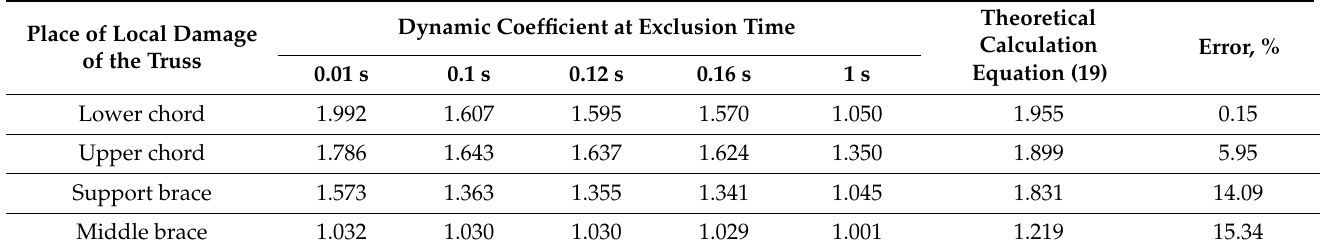
Table 2. Dynamic coefficients obtained by numerical and theoretical